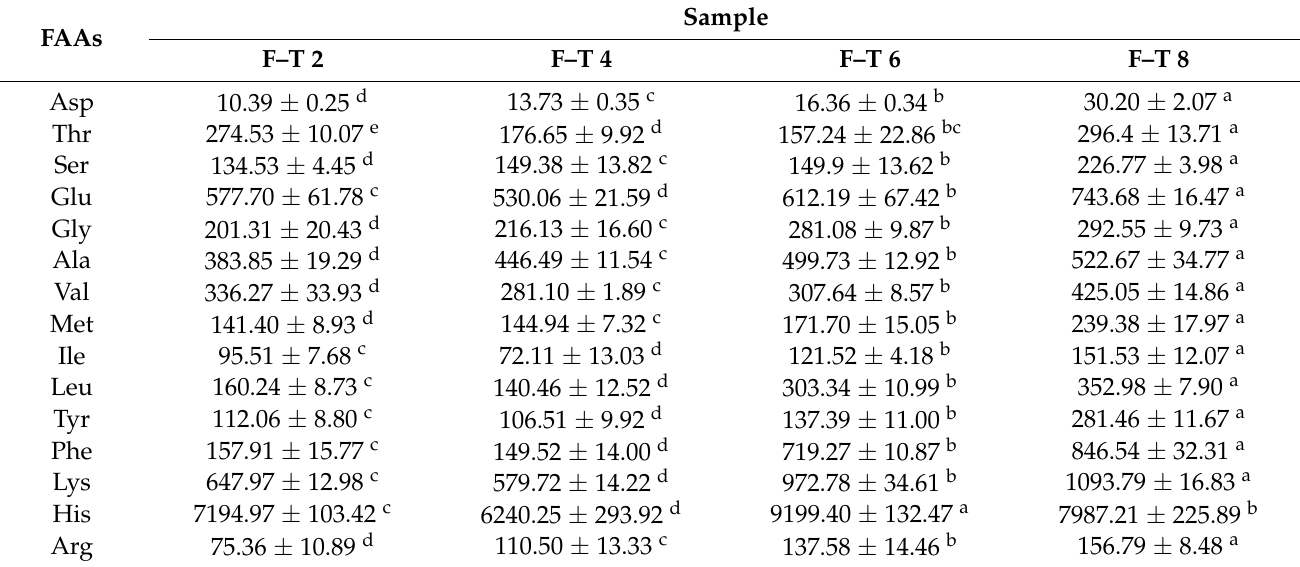
Table 3. Changes in the FAA content (ng/100 g) of T. murphyi in varying freeze–thaw (F–T)